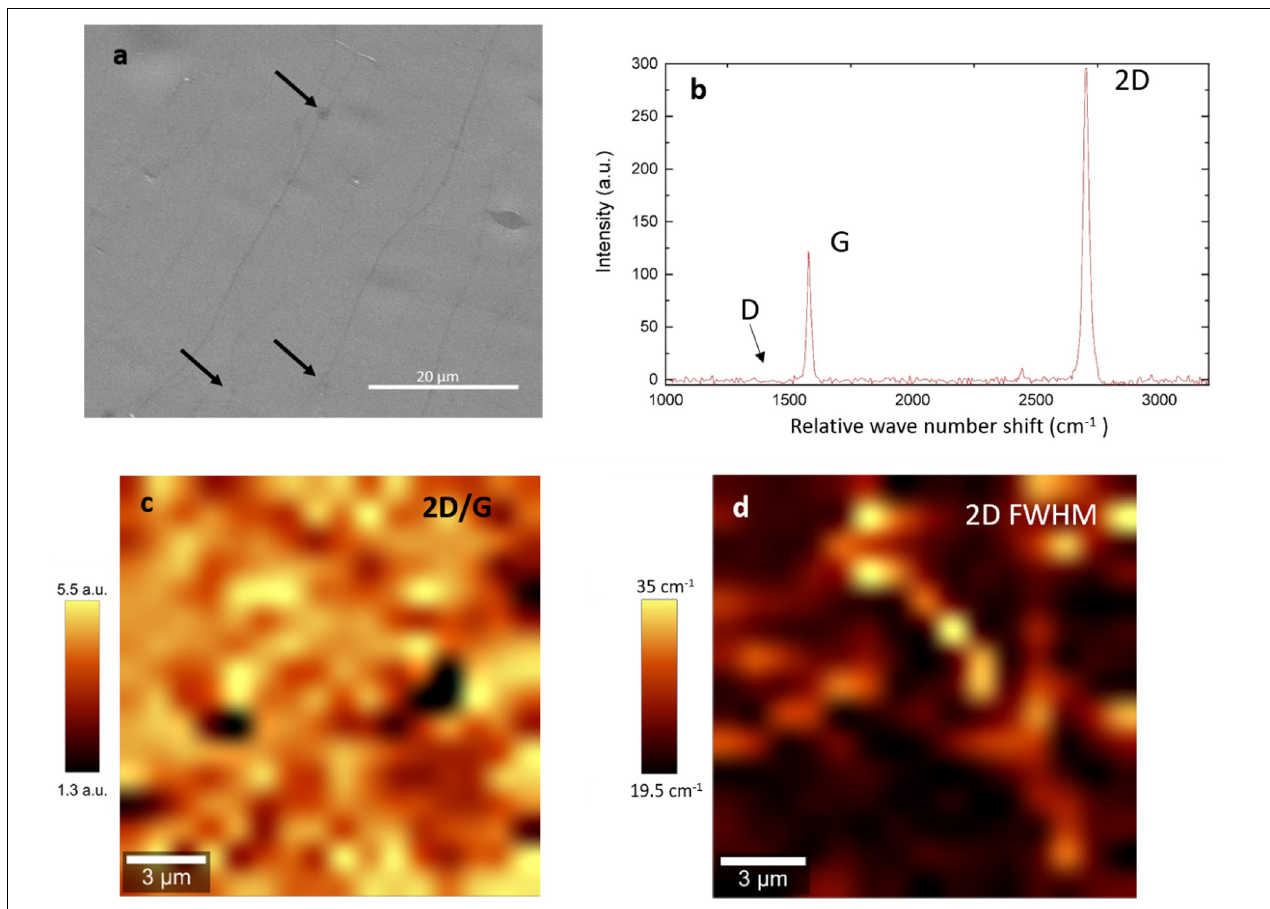
FIGURE 2 | SEM and Raman spectroscopy of the single layer graphene (a) SEM of graphene on copper. The black arrows show the position of the second nucleation, (b) representative Raman spectrum, no D band can be observed, (c) 2D/G mapping of a 15 µ m × 15 µ m area, (d) FWHM mapping of a 15 µ m × 15 µ m